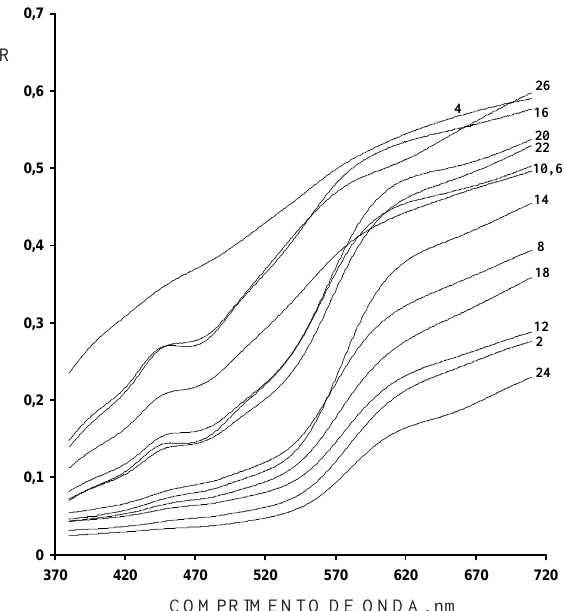
Figura 3. Espectros de refletância difusa (R) das amostras de TFSA correspondentes aos horizontes B